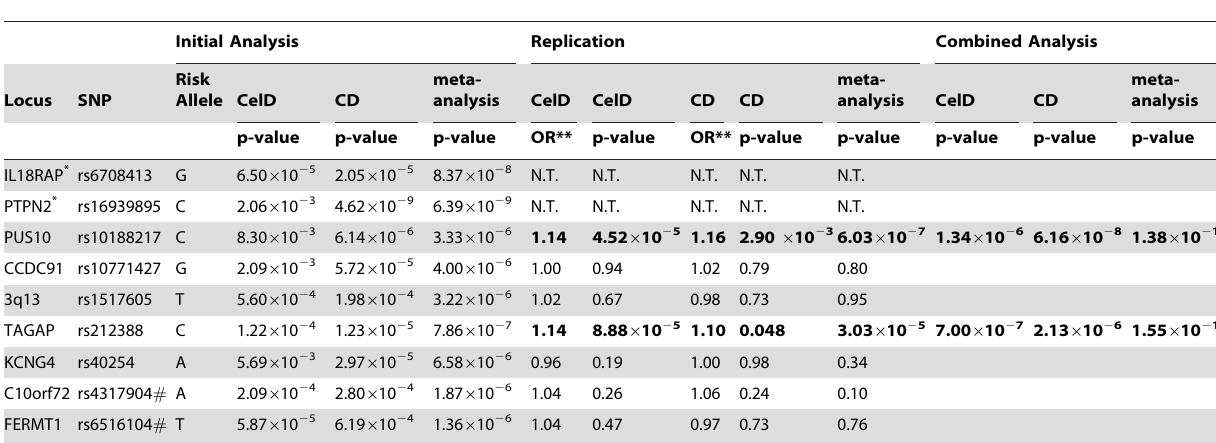
Table 1. Results from the meta-analysis, replication, and combined analysis.